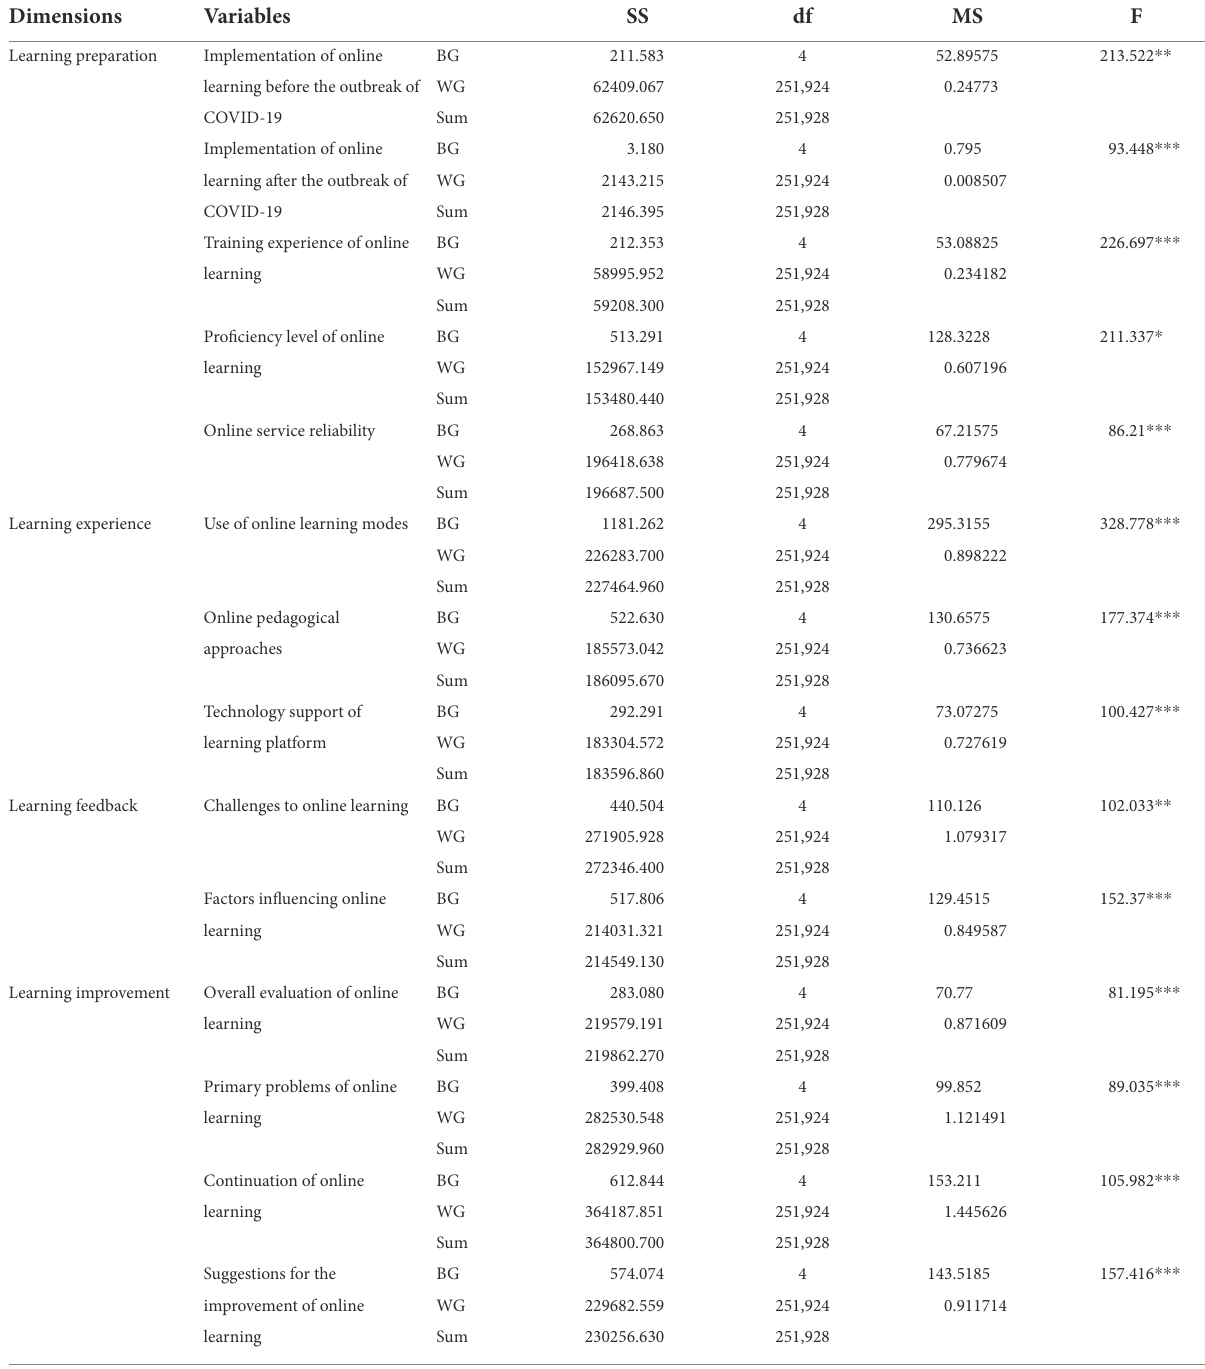
TABLE 7 Difference test of students’ online learning of different